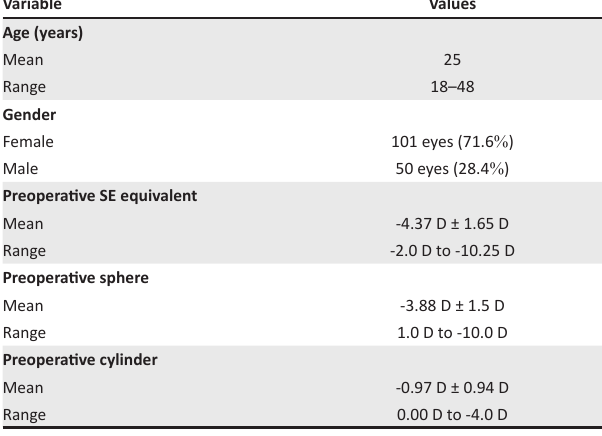
TABLE 1: Preoperative average values in the patient